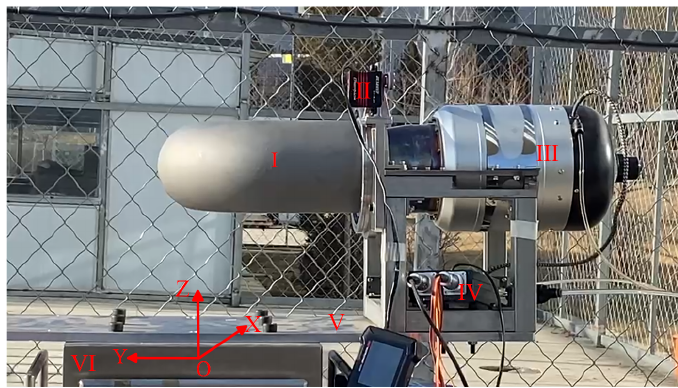
Figure 6. Experimental platform with a six-dimensional force balance. I: Nozzle; II: steering gear;